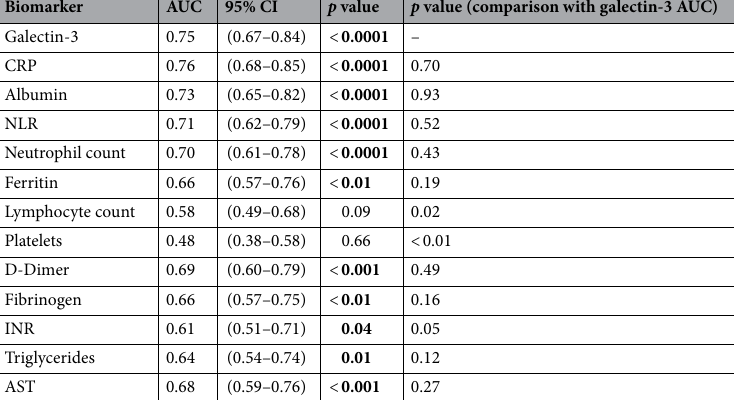
Table 2. Discrimination power of other inflammatory and thromboinflammatory markers for severe outcome and comparison with galectin-3. ROC curves were performed to determine the discrimination power of each biomarker for severe outcome. The AUC obtained was compared against that of galectin-3 using DeLong’s test for correlated ROC curves. Bold values represent p <